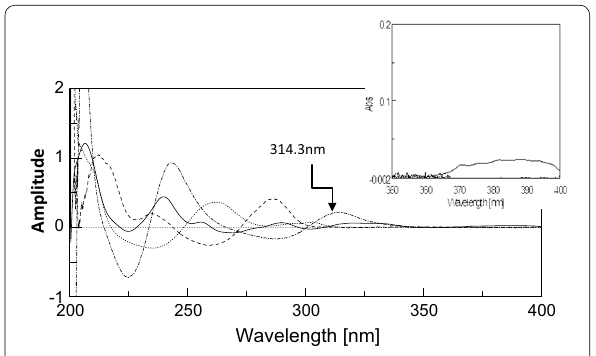
Fig. 3 First order absorption spectra of 10 μg/mL DRO ( solid line ), 10 μg/mL PCT ( dotted line ), 10 μg/mL CAF ( dashed line ) and 10 μg/mL PAP ( dashed dotted line )